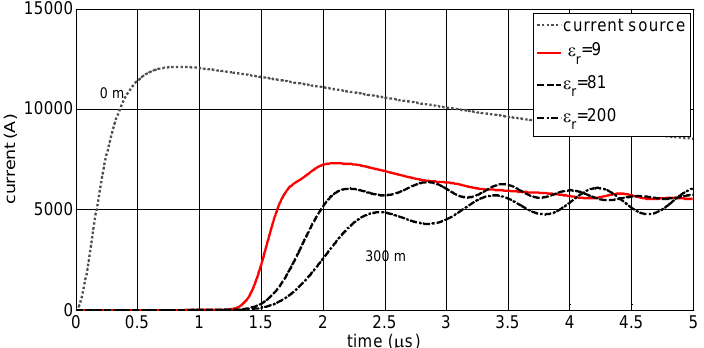
Figure 5. Current distribution along the lightning channel at height 300 m calculated by CST-MWS for a 4 × 4 m 2 parallelepiped dielectric of ε r = 9, ε r = 81, and ε r = 200 for σ = 0.0005 S/m. Model B 1: Wire embedded in a fictitious dielectric coating.